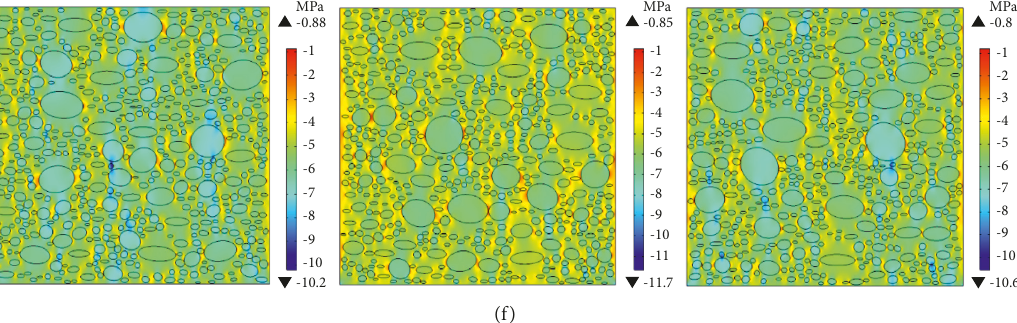
Figure 16: Stress distribution of concrete with different aggregate volume fraction. (a) σ (c) σ x of models 4, 5, and 9; (d) σ y of models 4, 5, and 9; (e) σ x of model 6 to model 8; (f) σ y model 6 to model